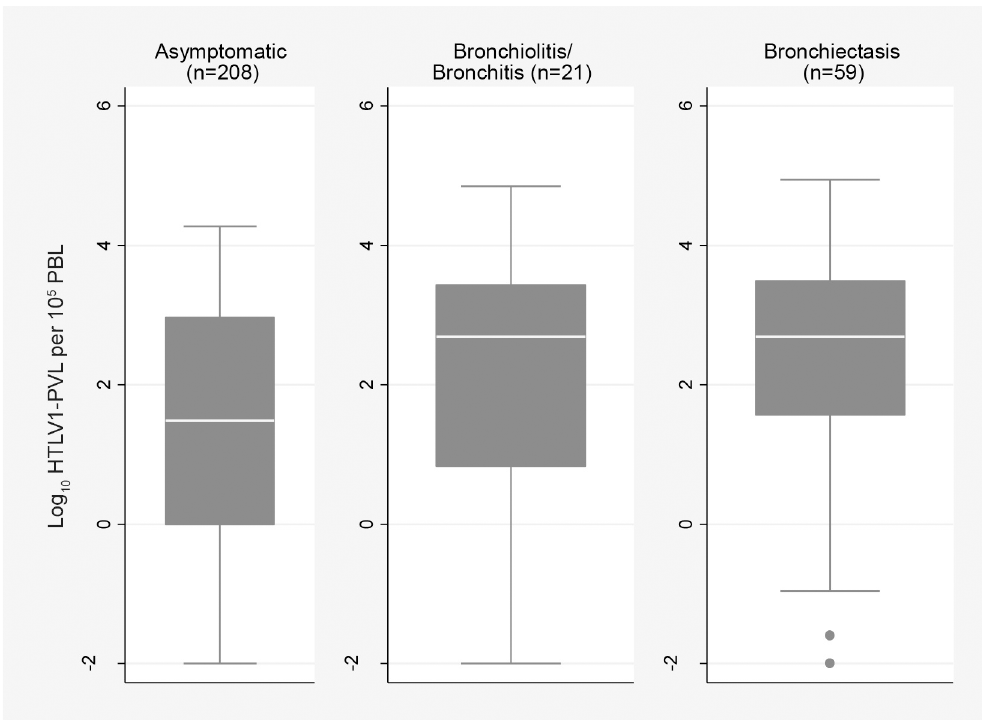
Fig 2. HTLV-1c proviral load compared between asymptomatic subjects, bronchiolitis/bronchitis and bronchiectasis. Subjects with chronic airways disease were examined by chest high resolution computed tomography. Median (IQR) HTLV-1c pVL for subjects with bronchiolitis/bronchitis (2.69 (0.82, 3.43) log 10 copies per 10 5 PBL) and bronchiectasis (2.69 (1.57, 3.49) log 10 copies per 10 5 PBL) were significantly higher than that of the asymptomatic group (1.48 (-0.001, 2.97) log 10 copies per 10 5 PBL)(asymptomatic vs bronchiectasis, p = 0.001; asymptomatic vs bronchitis/bronchiolitis, p = 0.042). Asymptomatic subjects exclude: i) those with other HTLV-1 associated conditions (infective dermatitis, 2; probable HAM/ TSP, 2; uveitis, 2; crusted scabies, 4; ATL; 1), ii) five subjects with a discharge diagnosis of bronchiectasis without radiological evidence of bronchiectasis, bronchitis or bronchiolitis and iii) three subjects who presented with neurological symptoms for whom HAM/TSP could not be excluded due to cognitive impairment.